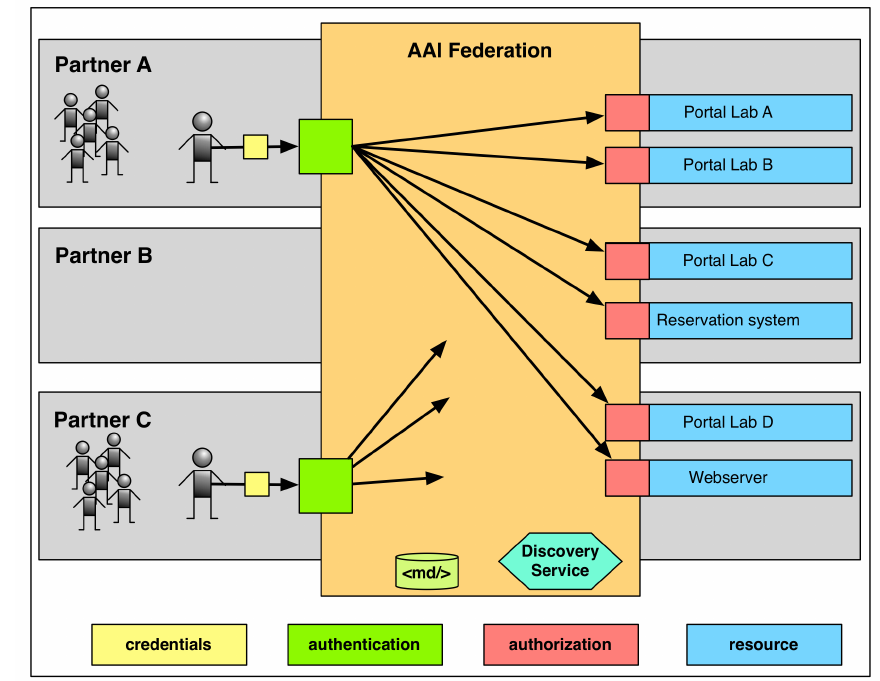
Figure 2. Authentication with a federated